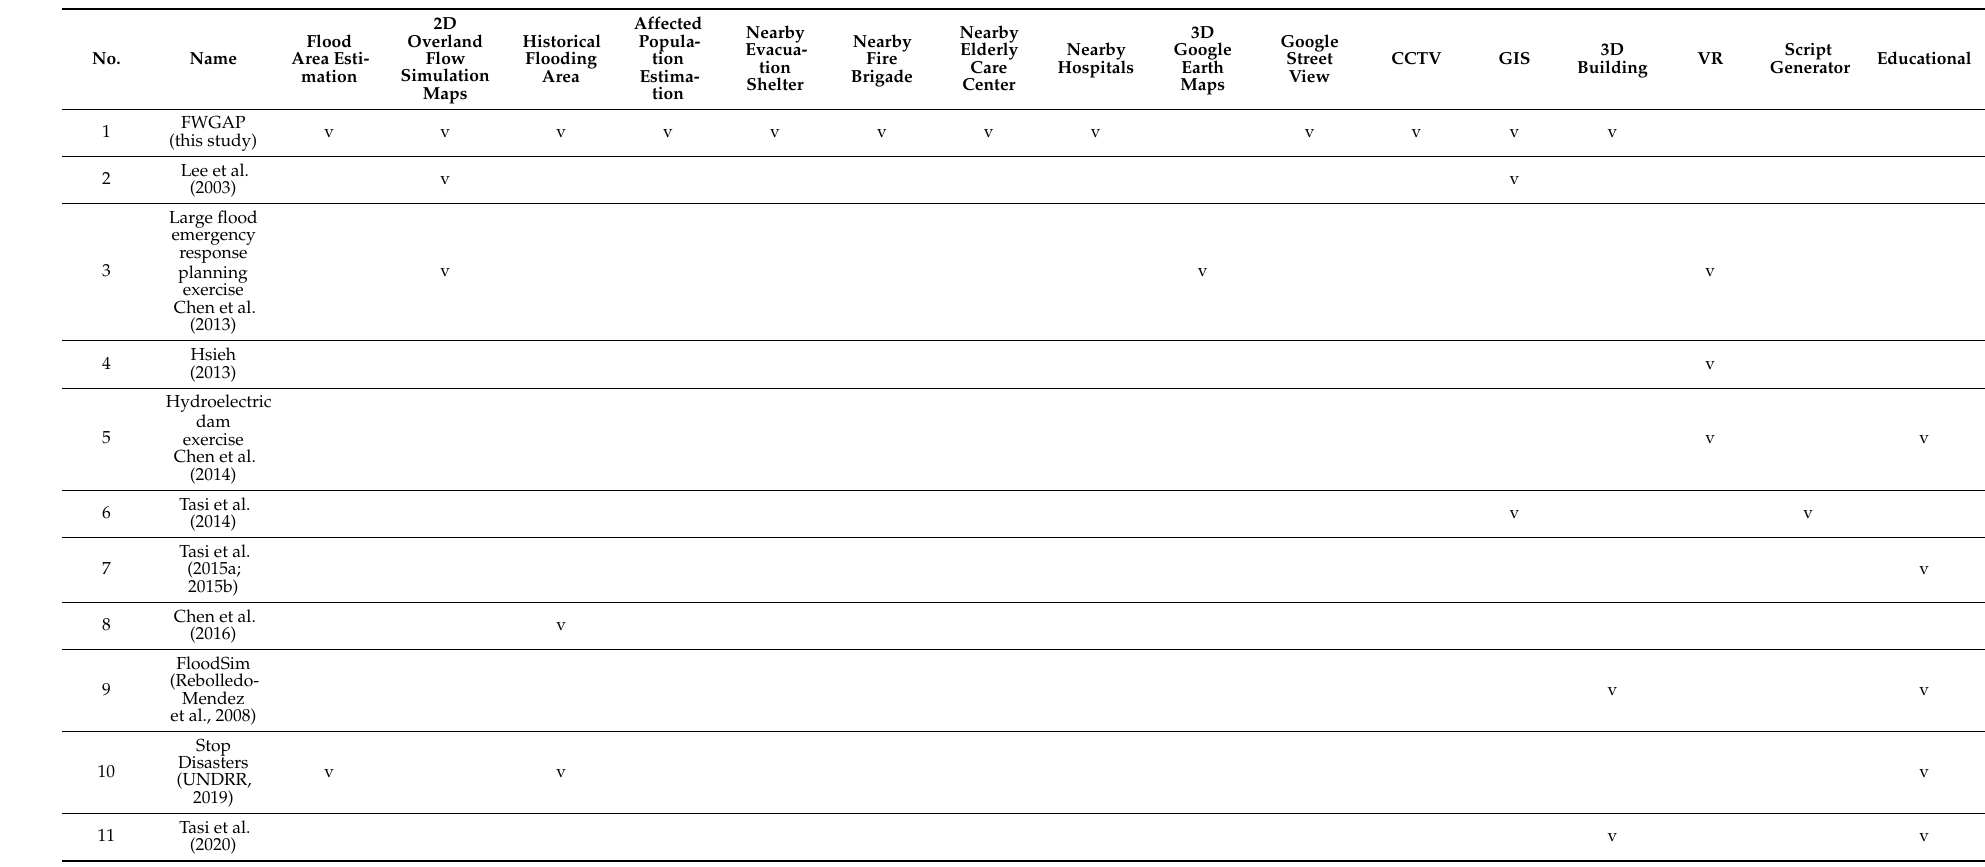
Table 1. The functions of different computer-aided, flood-related disaster